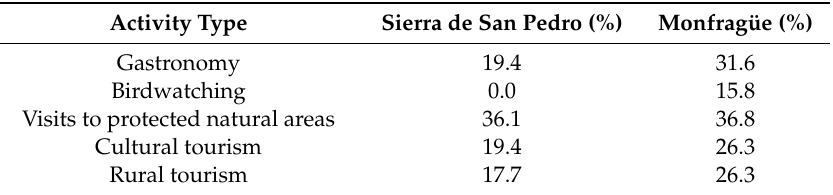
Table 10. Hunting tourism activities.